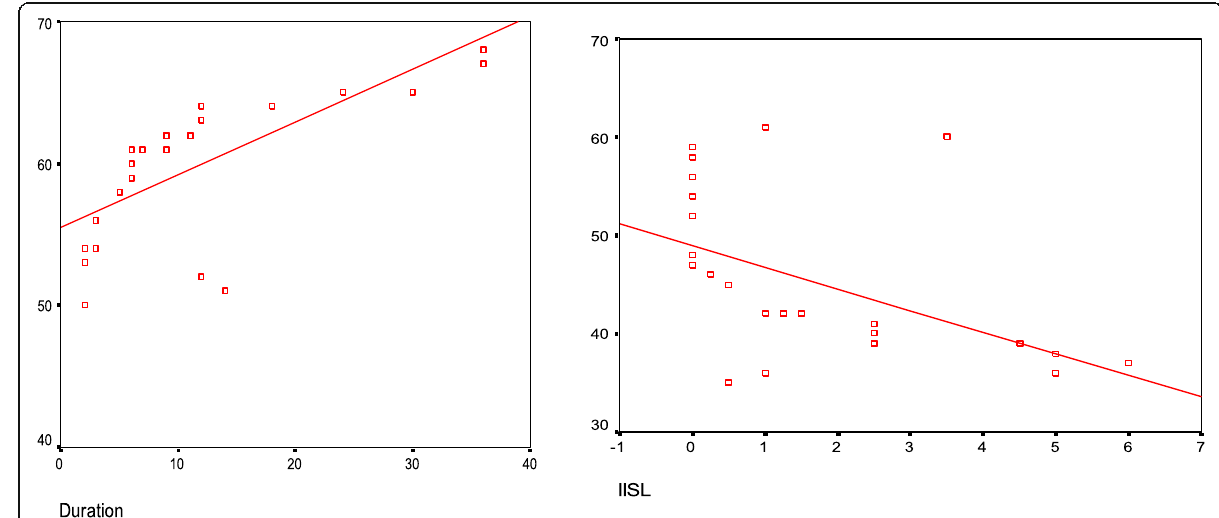
Fig. 1 Positive correlation between disease duration and thought problem (left), and a negative correlation between IISL and WCST